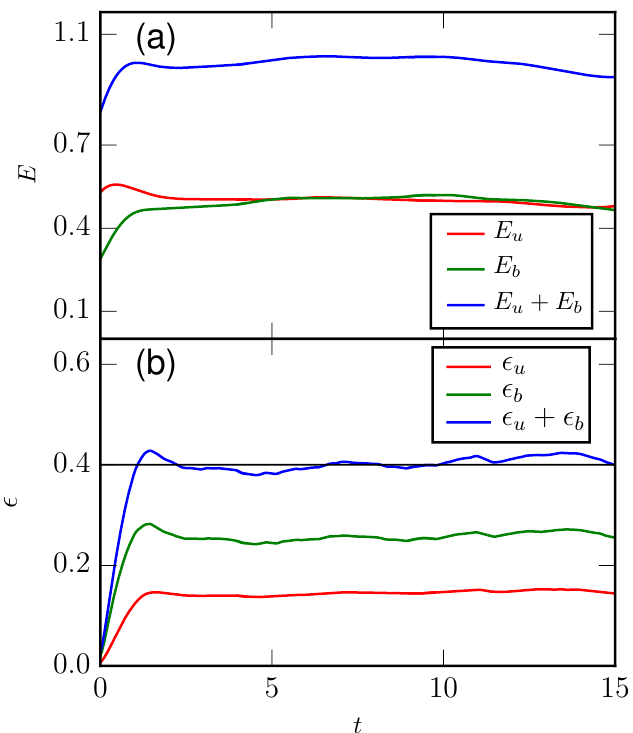
Figure 2. The evolution of ( a ) kinetic energy (solid red curve), magnetic energy (solid green curve) and total energy (solid blue curve), and ( b ) kinetic, magnetic and total dissipation rates with the same color scheme. Note that the solid black curve shows the total-energy injection rate (cid:101) inj =